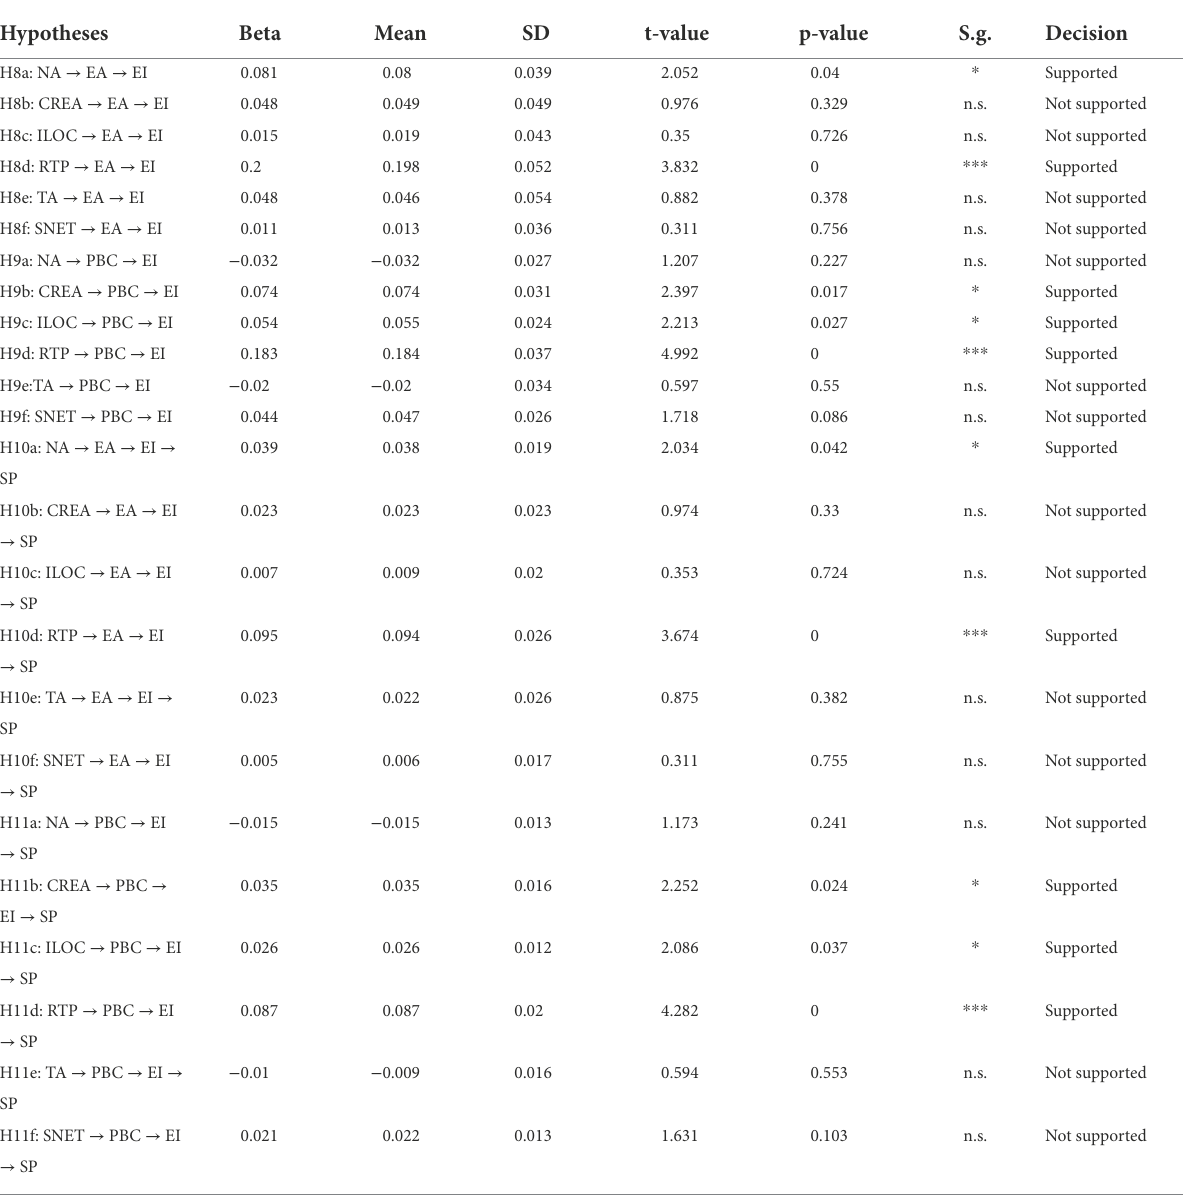
TABLE 9 Special indirect